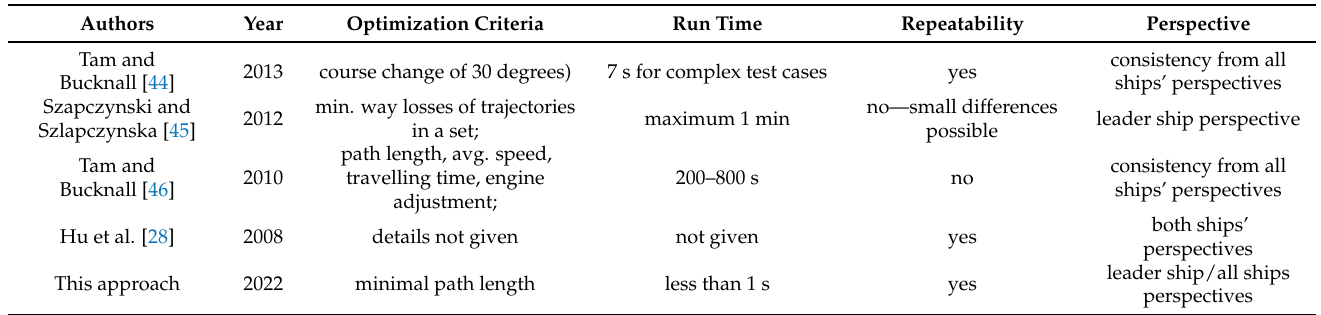
Table 15. Comparison of collision avoidance algorithms applicable in maneuver auto-negotiation systems—part